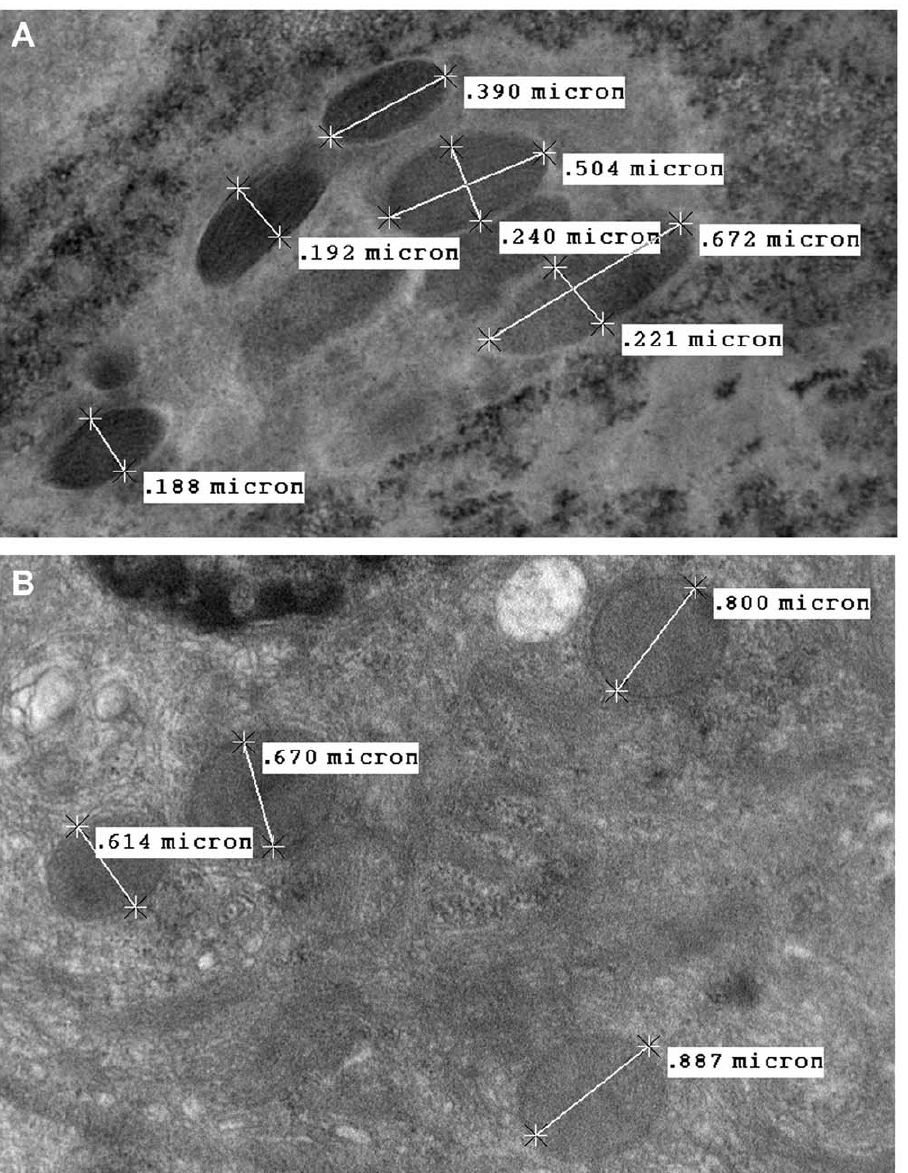
Figure 1. Rod shaped (A) and spherical (B) structures resembling Las in ovaries of Las-infected female D.citri observed with transmission electron microscopy. Ovaries from female psyllids that were confirmed negative for Las by qPCR were devoid of structures similar to those observed from positive females following an identical microscopic evaluation.